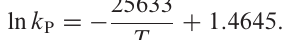
/ and A t for phosphorus removal at different temperatures. C V